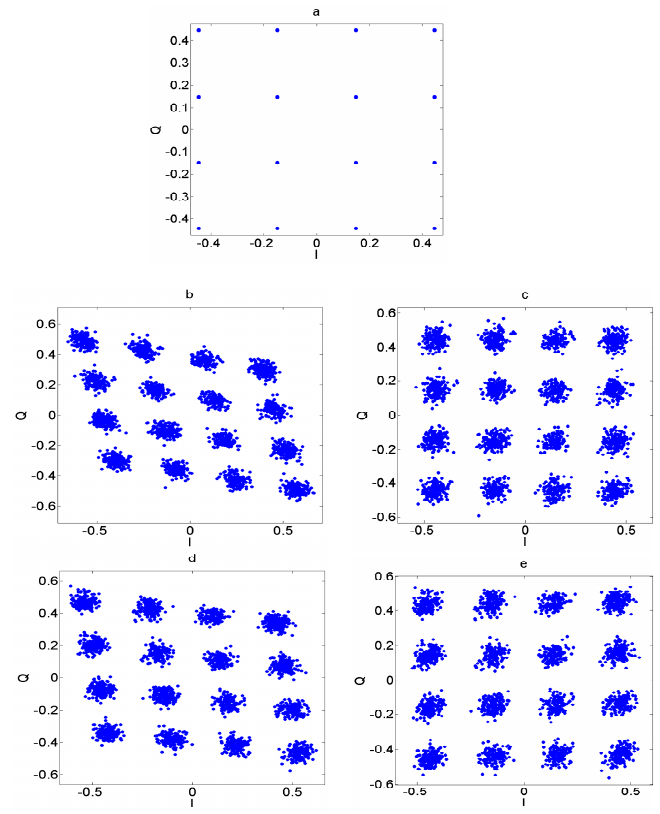
Figure 11. Constellation of 16 QAM signals under 20 dB SNR ( a ) transmitted signal ( b ) received signal and ( c ) corrected signal for g = g’ = 0.92 dB and θ = θ ’ = − 6 degrees; ( d ) Received and ( e ) corrected signal for g = 0.92 dB, g’ = 0.5 dB and θ = − 6 degrees, θ ’ = − 2 degrees.